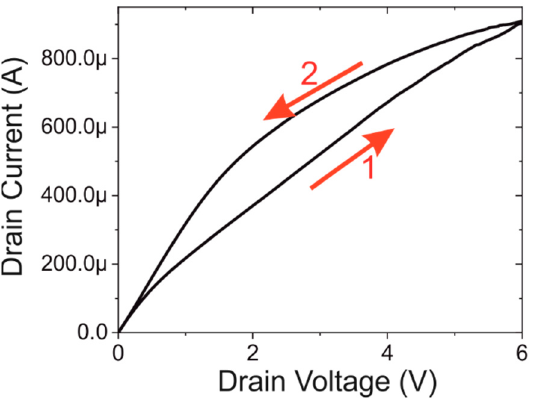
Figure 4. IV-characteristics of a functionalised device with a spike protein concentration of 1 pM. The arrows and numbers indicate the direction of the voltage sweep. During the upsweep (1) a FET type characteristic is observed, and the return sweep (2) show hysteresis caused by slow moving ions.